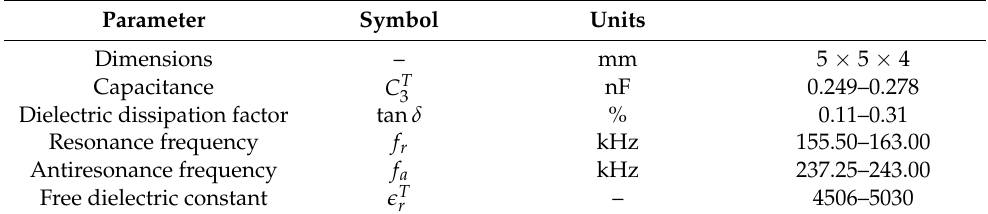
Table 4. Characteristics of fabricated PMN-PT piezoelectric single crystals.